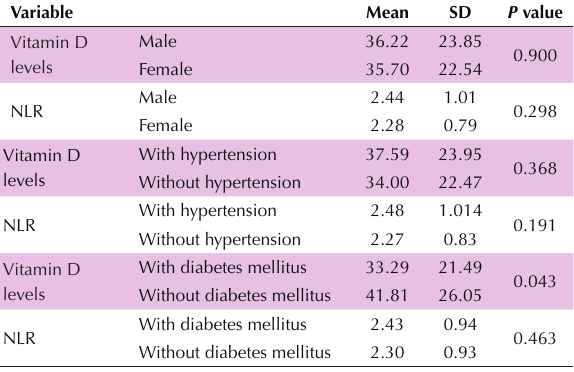
Table 2. Comparison of the serum 25-hydroxy vitamin D levels and NLR across gender, DM and HTN Variable Mean SD